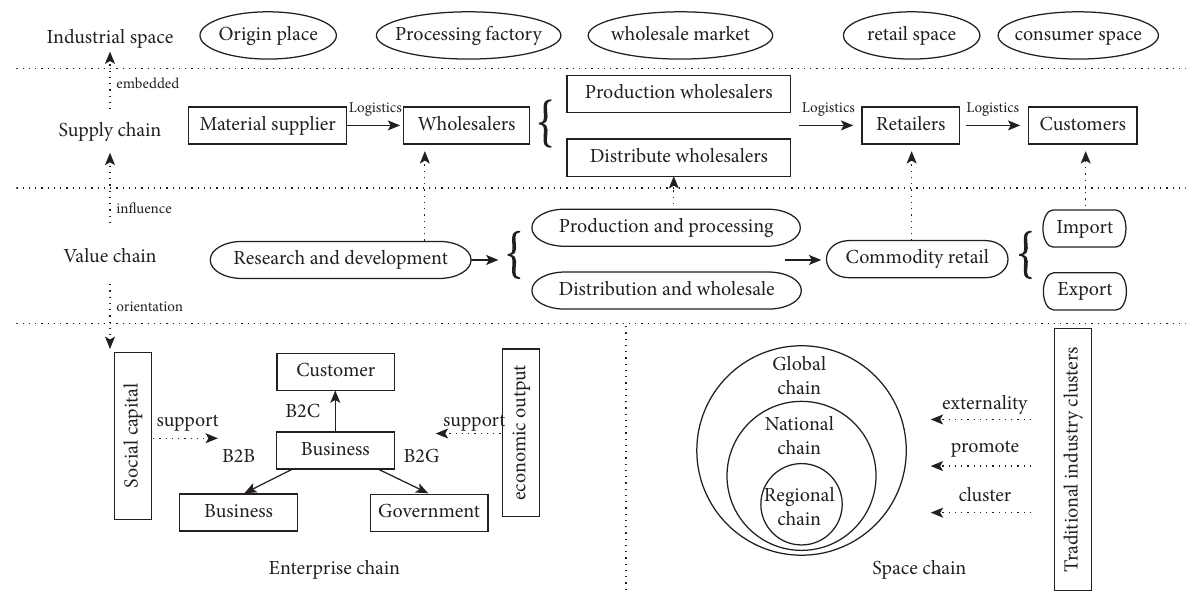
Figure 3: The embeddedness relationship between e-commerce industrial chains and industry